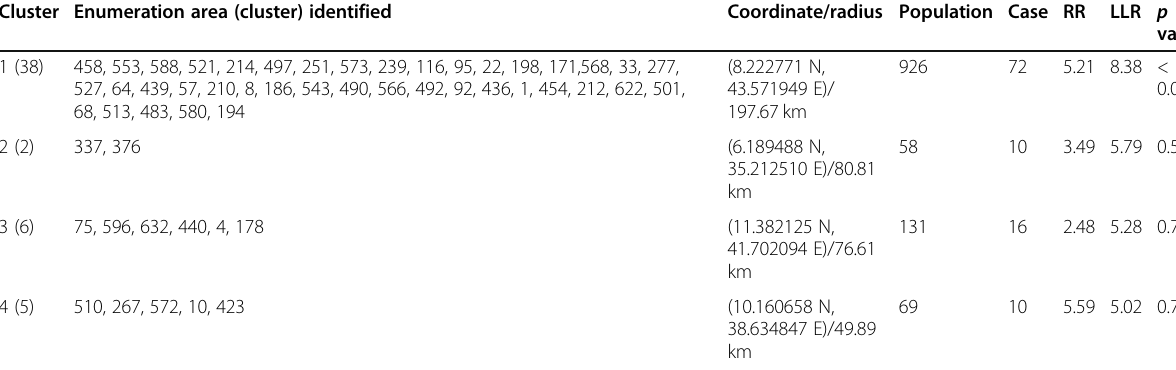
Table 5 Spatial scan statistical analysis of hotspot areas of infant mortality in Ethiopia, 2016 Cluster Enumeration area (cluster)